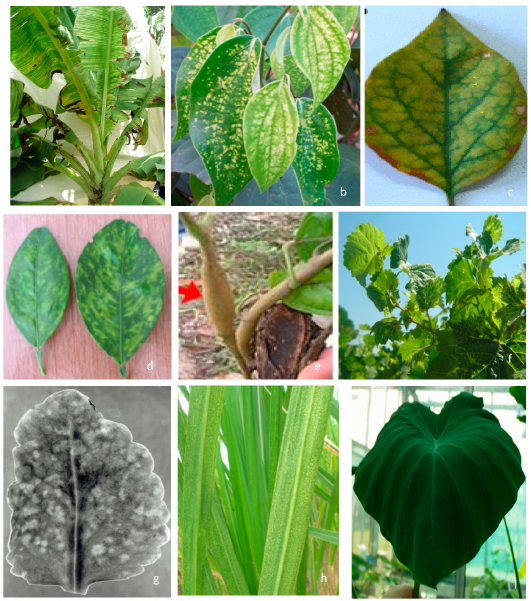
Figure 2. Symptoms of the diseases caused by badnaviruses. ( a ) chlorotic streaks in banana (Source: